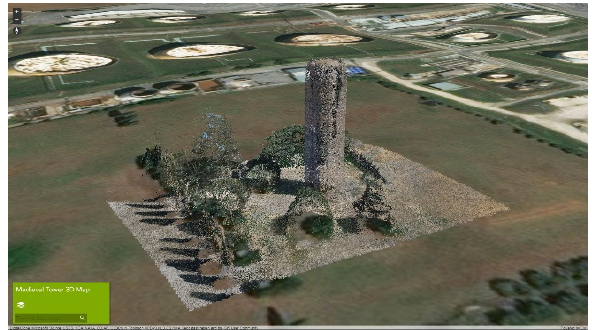
Figure 11. 3D Web App on ArcGIS